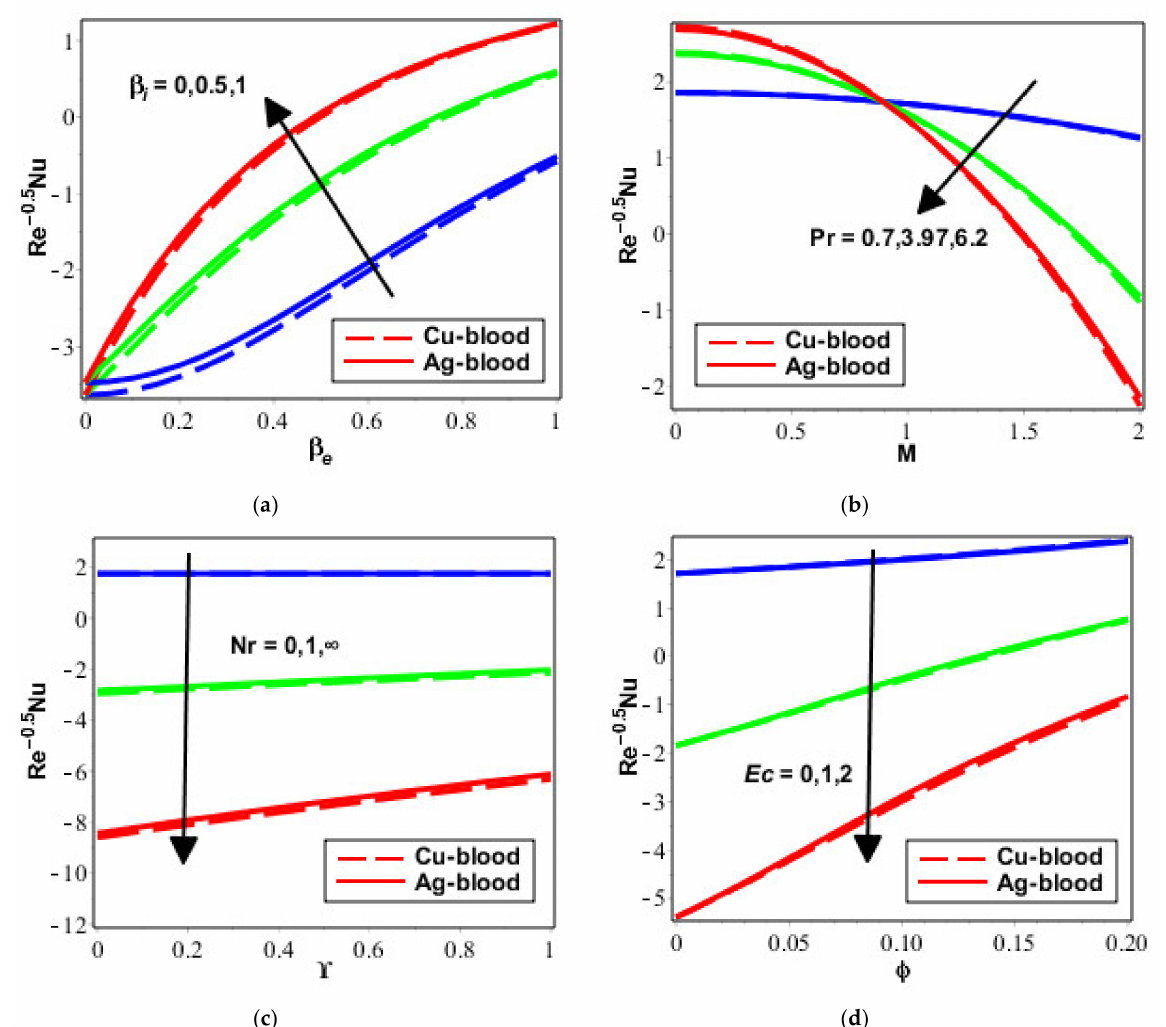
Figure 13. Behaviour of Re − 1 2 Nu as varying ( a ) β i and β e ( b ) Pr and M ( c ) Nr and Y ( d ) Ec and φ